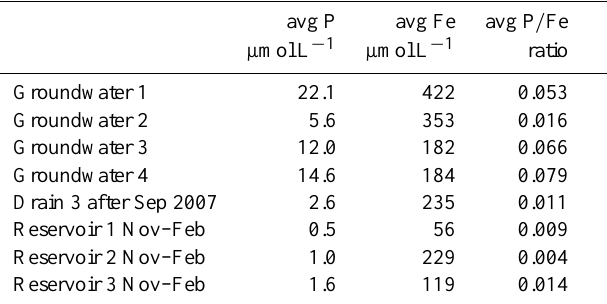
Table 1. Averaged P and Fe concentrations and molar P / Fe ratios of the groundwater, the reservoir water during winter time and the drain 3